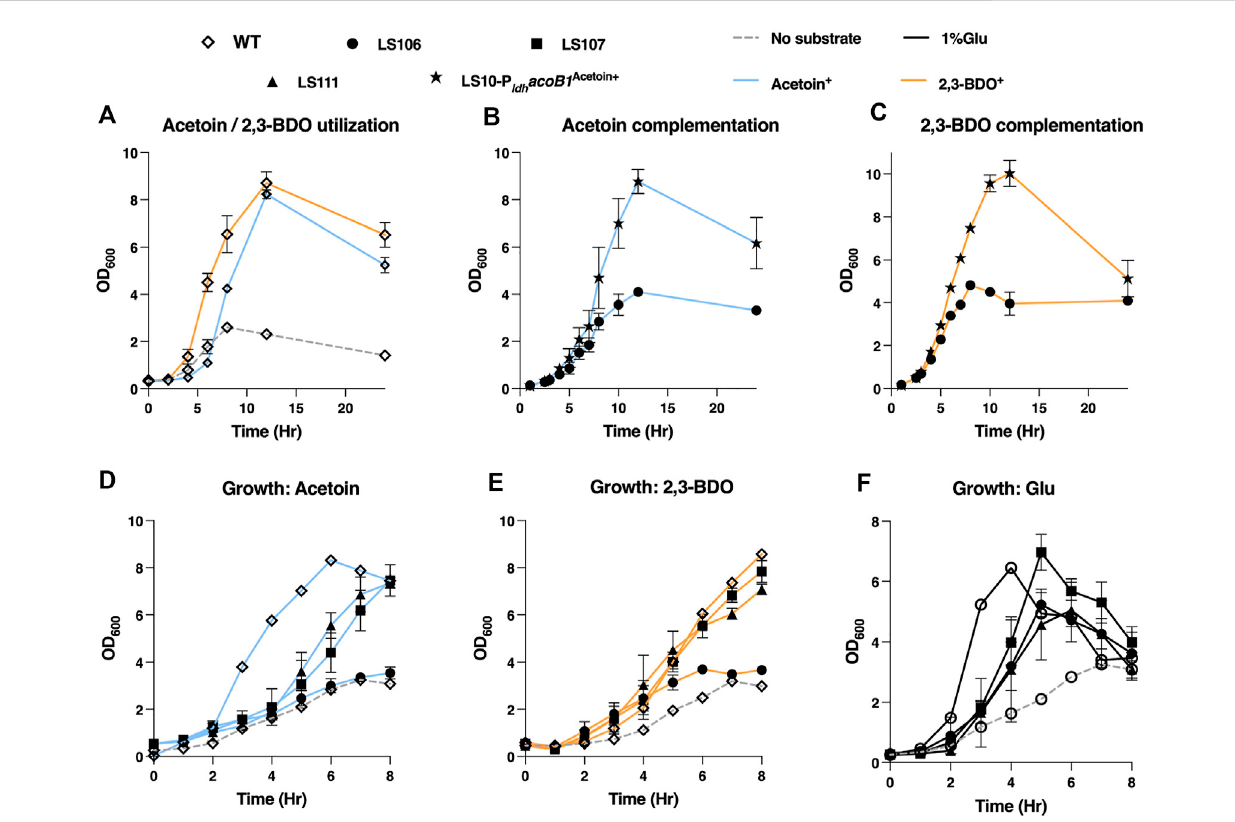
FIGURE 6 Testing the ability of P. thermoglusidasius NCIMB 119 to consume acetoin and/or 2,3-BDO. (A) Growth curve of P. thermoglusidasius NCIMB 11955onacetoin(AC)and2,3-BDO(BDO)asthesolesourceofcarbon. (B) GrowthonacetoinofNCIMB11955deletionmutants Δ acoB1 (LS106), Δ acoB2 (LS107) and Δ acuA-C (LS111). (C) Growth on2,3-BDO ofLS106,LS107 andLS111. (D) Growth ofLS106,LS107 and LS111on glucose. (E) Complementation of LS106 growth on acetoin through plasmid-based overexpression the acoB1 gene. (F) Complementation of LS106 growth on 2,3-BDO through plasmid-based overexpression the acoB1 gene. In all cases, time zero = inoculation of overnight liquid culture to OD 600 of 0.25 – 0.5. Cells were propagated at 60 ° C in CBM with a 1% (w/v) carbon source and shaking (250 rpm) in 250 mL baf fl ed fl asks. CBM without a carbon source was used as negative control. Error bars represent the standard deviation of three biological replicates.